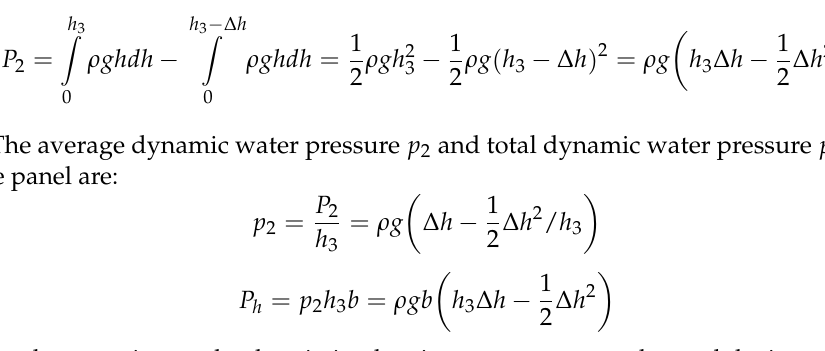
Figure 3. Schematic diagram of the herringbone gate subjected to wind pressure. The size of the liquid pressure depends only on the type and depth of the liquid, and the quality of the liquid. The total dynamic water pressure per unit width of the door leaf panel along the door axis direction is